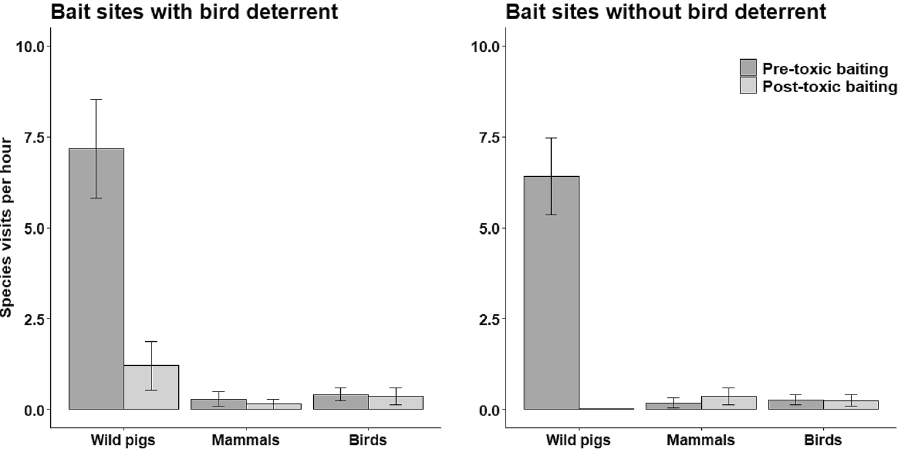
Figure 6. Index of species visitation to SN-toxic bait sites for wild pigs one day pre- and post-toxic baiting in north-central Texas, USA during July